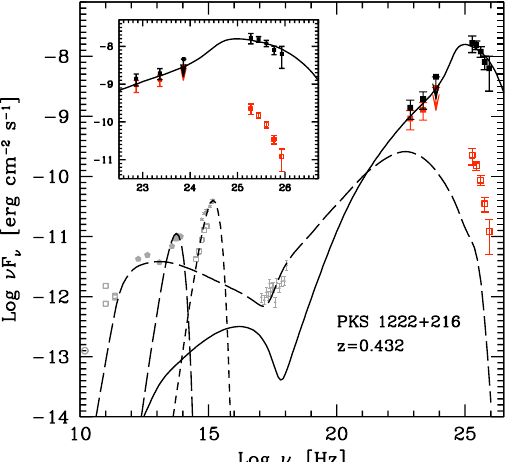
Figure 14. Red points at high energy and open red squares at VHE are the spectrum of PKS 1222+216 recorded by Fermi/LAT and the one observed by MAGIC. The black points represent the same data once further corrected for the photon-ALP oscillation effect in the case ( B = 0.2G, g a γγ = 1.4 · 10 − 11 GeV − 1 ). So, they are obtained from the red points and the open red squares by means of Equation (119). The gray data points below 10 20 Hz are irrelevant for the present discussion (details can be found in [238]). In addition, the dashed and solid curves show the SED resulting from the considered two blobs which account for the γ -ray emission at high energy and VHE, respectively. (Credit